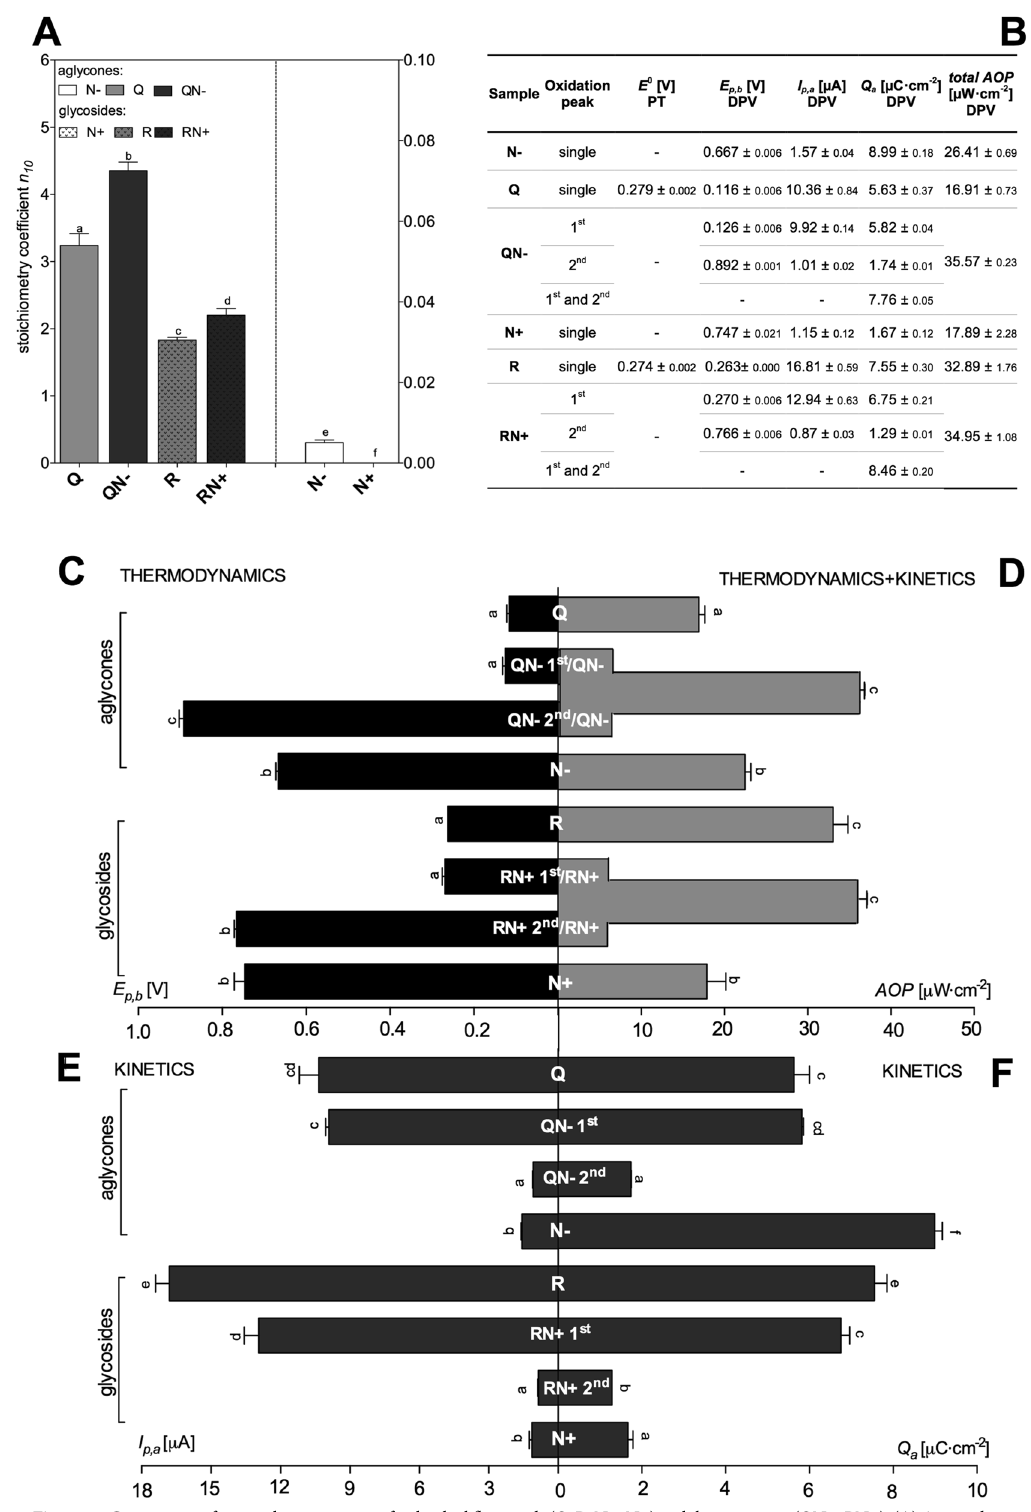
Figure 2. Comparison of antioxidant properties of individual flavonoids (Q, R, N−, N+) and their mixtures (QN−, RN+). ( A ) Antioxidant activity expressed as stoichiometry coefficient n 10 calculated based on the DPPH test (as defined in section “Antioxidant activity by differential pulse voltammetry”). ( B ) The values of standard reduction potential ( E 0 ) measured by potentiometric titration (PT) and potential of oxidation peak vs standard hydrogen electrode ( E p,b ), anodic peak potential ( I p,a ), charge density of the process ( Q a ), and the antioxidant power considering 1 st and 2 nd stage of oxidation process ( total AOP ) at concentration 3 mM determined by DPV ( v = 0.1 V·s −1 ). ( C ) Thermodynamic characterization by E p,b . ( E , F ) kinetic properties described by Q a and I p,a . ( D ) combination of thermodynamic and kinetic parameter expressed as antioxidant power ( AOP ). In the case of mixtures, two anodic peaks were observed (1 st related to Q/R and 2 nd related to N−/ N+ in the mixture). All results are given as means ± SD of three independent determinations. Different letters indicate a significant difference determined by one-way ANOVA with Tukey’s test ( p ≤